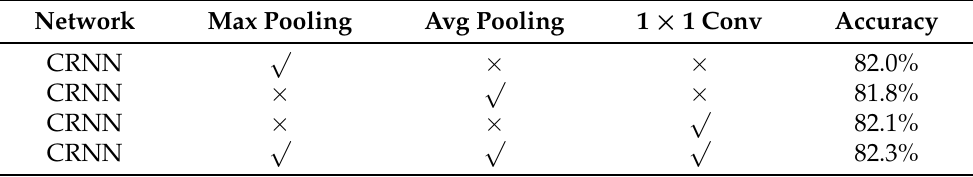
Table 5. Classification accuracy comparison for max and average pooling, and 1 × 1 convolution. Network Max Pooling Avg Pooling 1 × 1 Conv Accuracy